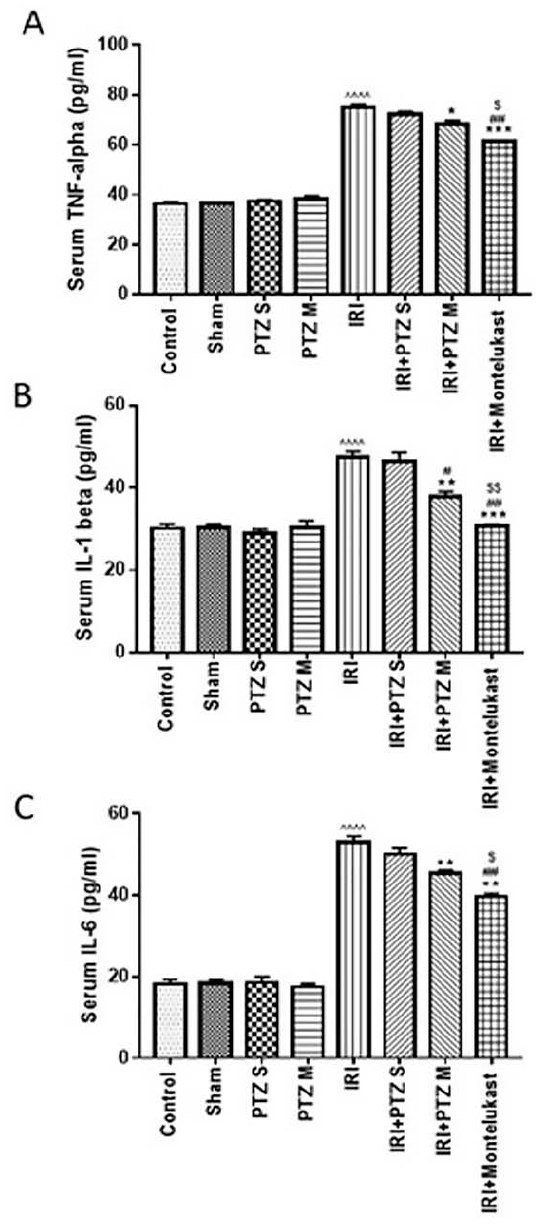
Figure 2. Effect on levels of inflammatory cytokines. Serum levels of ( A ) TNF- α , ( B ) IL-1 β , and ( C ) IL-6 (pg/mL) for the different groups. Bars represent mean ± SEM. Significant difference between groups is analyzed by Student’s t -test after one-way ANOVA test ( n = 8), where ˆˆˆˆ: p < 0.0001, compared to normal control group. *: p < 0.05, **: p < 0.01, ***: p < 0.001, compared to IRI group. #: p < 0.05, ##: p < 0.01, compared to (IRI + PTZ S) group. $: p < 0.05, $$: p < 0.01, compared to (IRI + PTZ M) group.